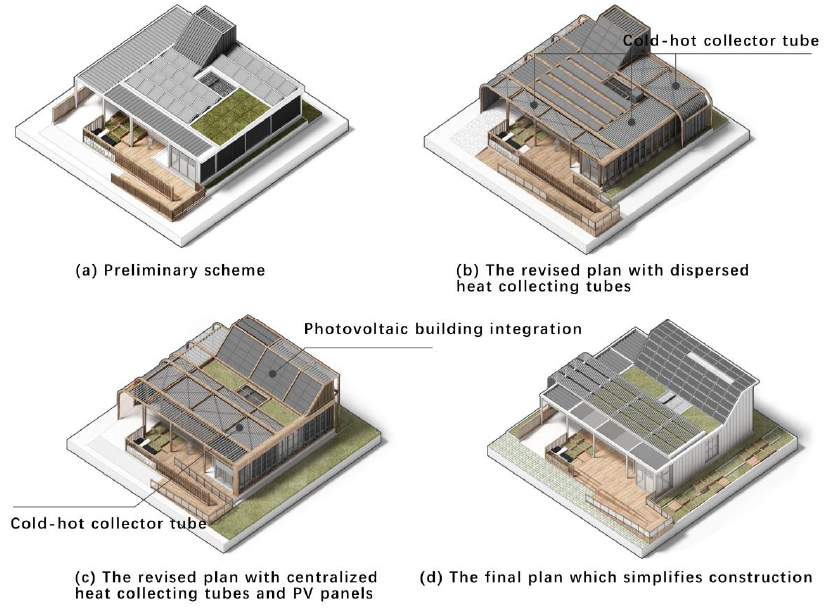
Figure 16. The optimization of building shape through the collector and PV panels design.